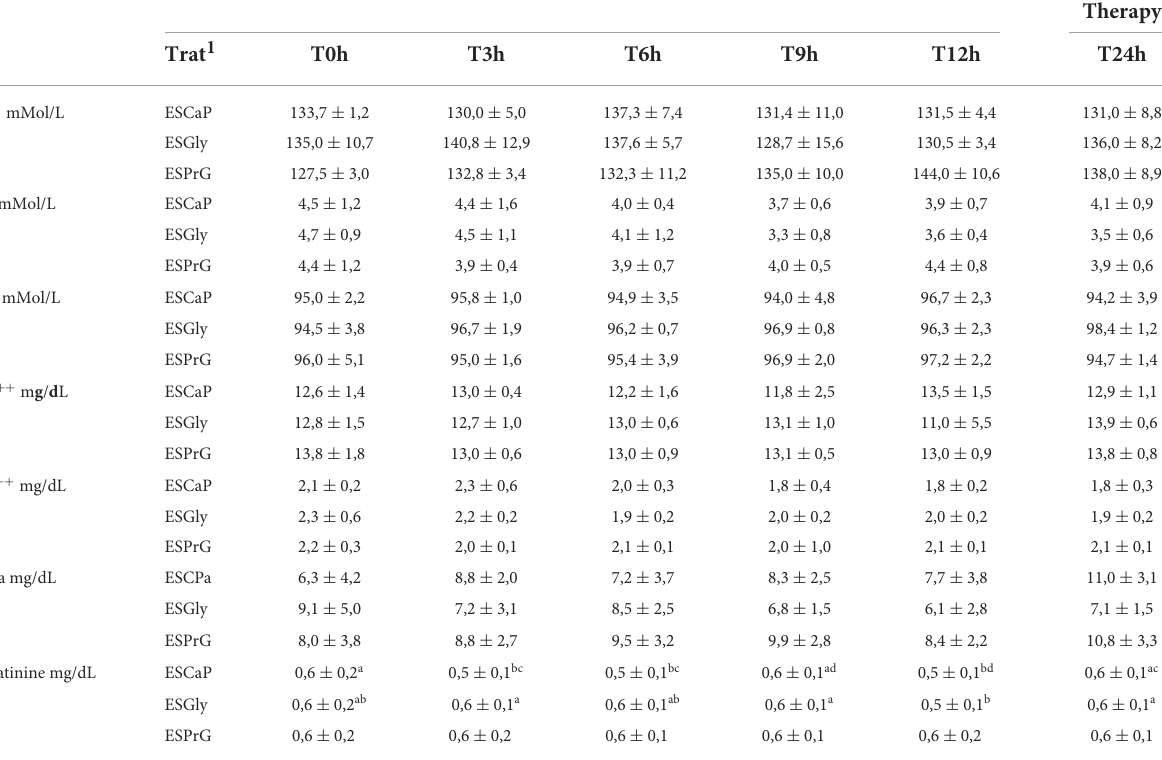
TABLE 1 Mean ± standard deviation of serum electrolytes sodium (Na + ), potassium (K + ), chloride (Cl − ), total calcium (tCa ++ ) magnesium (Mg ++ ), urea, and creatinine in cattle submitted to continuous flow enteral fluid therapy with three electrolyte solutions containing different energy precursors.